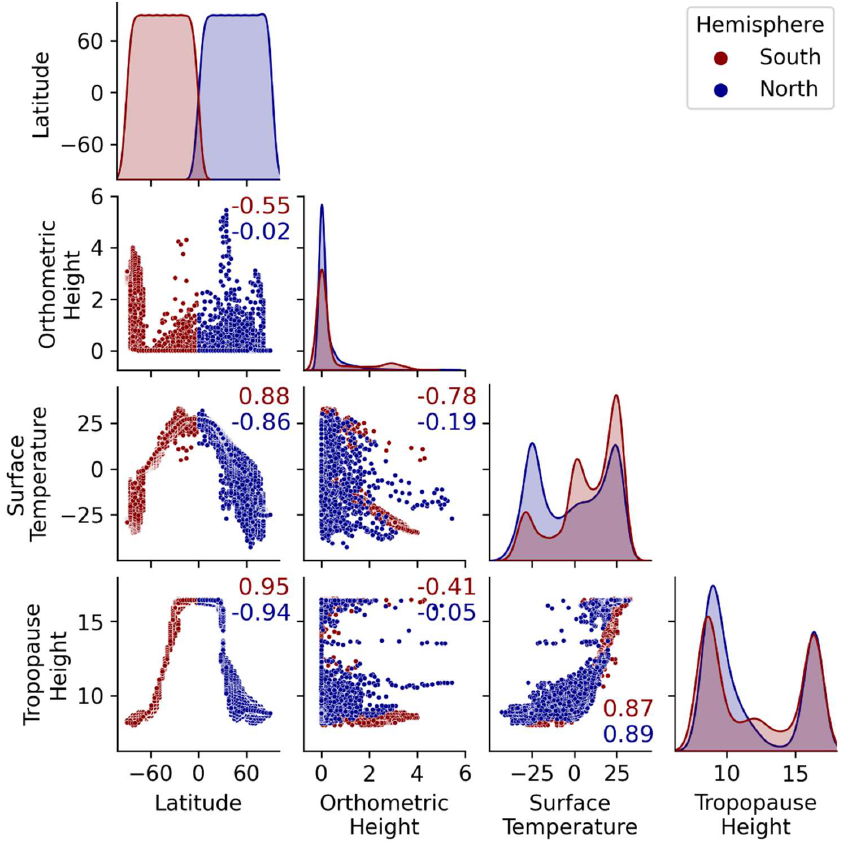
Figure 5. Lower triangular matrix of correlations between tropopause, latitude, orthometric height, and surface temperature for 16,380 grid points (for January). The diagonal terms are the kernel density estimate (KDE) corresponding to the different variables. The off-diagonal terms are the scatter plots for each variable pair; the number expresses their Pearson correlation coefficient. Red color for the southern hemisphere and blue color for the northern hemisphere. Latitude is in degrees, the surface temperature in degrees Celsius, orthometric height, and tropopause height are in